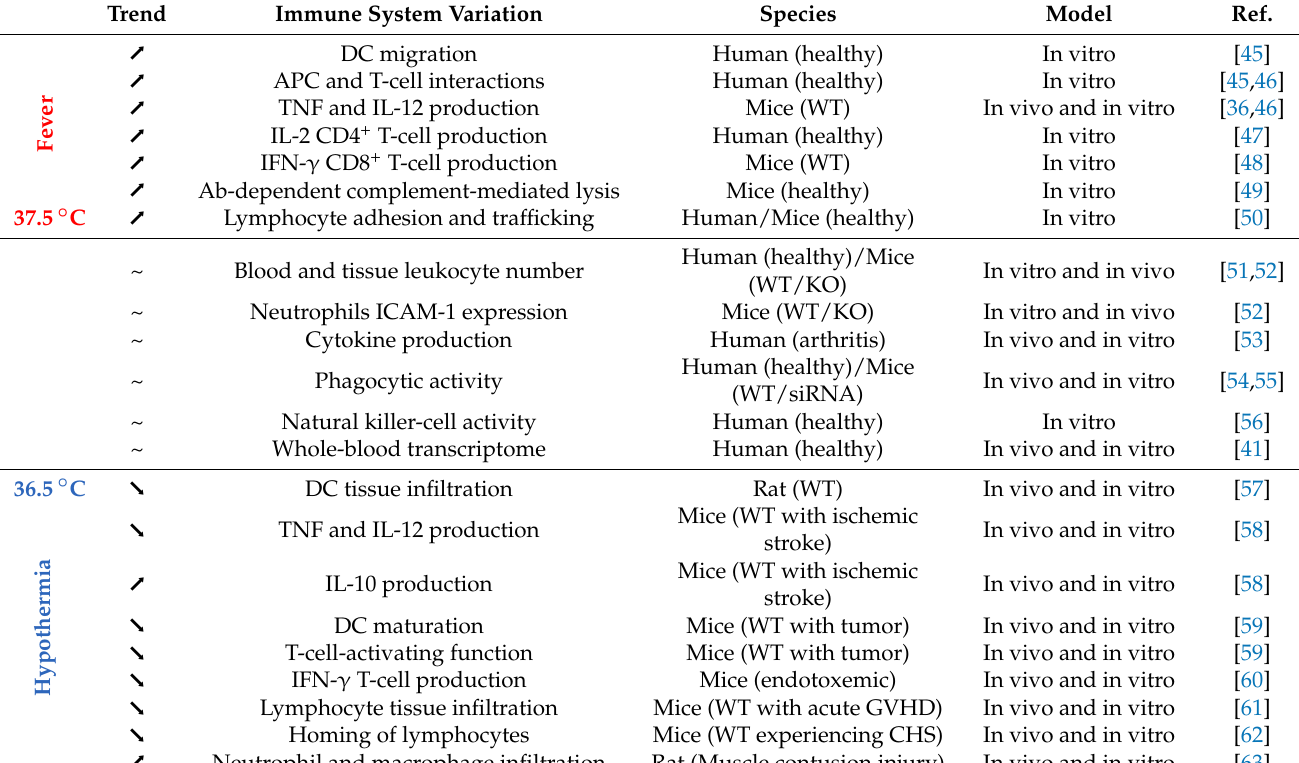
(or heat) and hypothermia. CHS—contact hypersensitivity; GVHD—graft-versus-host disease; KO—knock-out; WT—wild type.